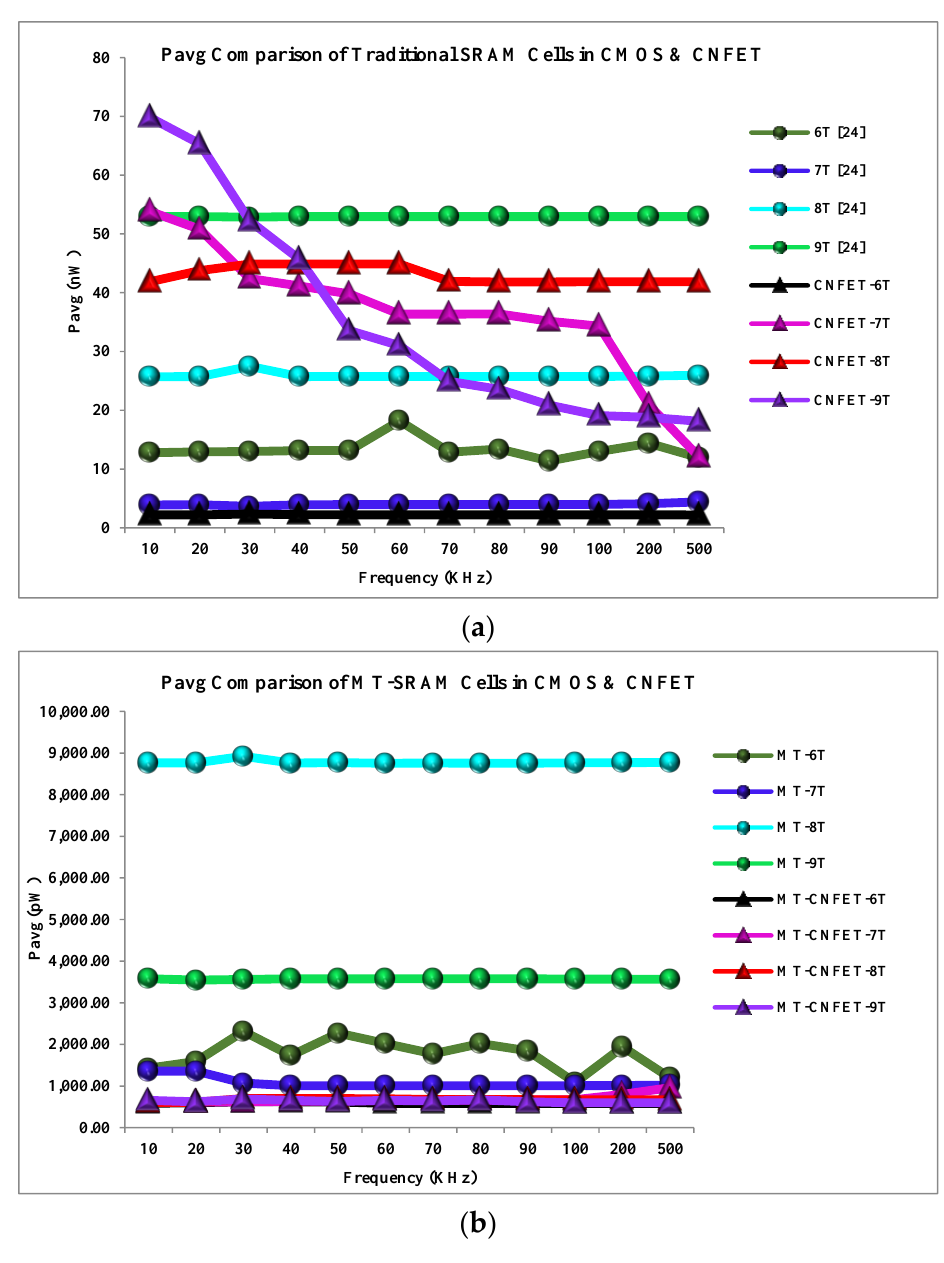
Figure 13. ( a ) Pavg Comparison of Traditional SRAM Cells in CMOS and CNFET. ( b ) Pavg Comparison of Proposed MT-SRAM Cells in CMOS and CNFET. Table 7. Pavg Comparison (%)–CNFET 6T SRAM Cell vs. Other SRAM Cells.